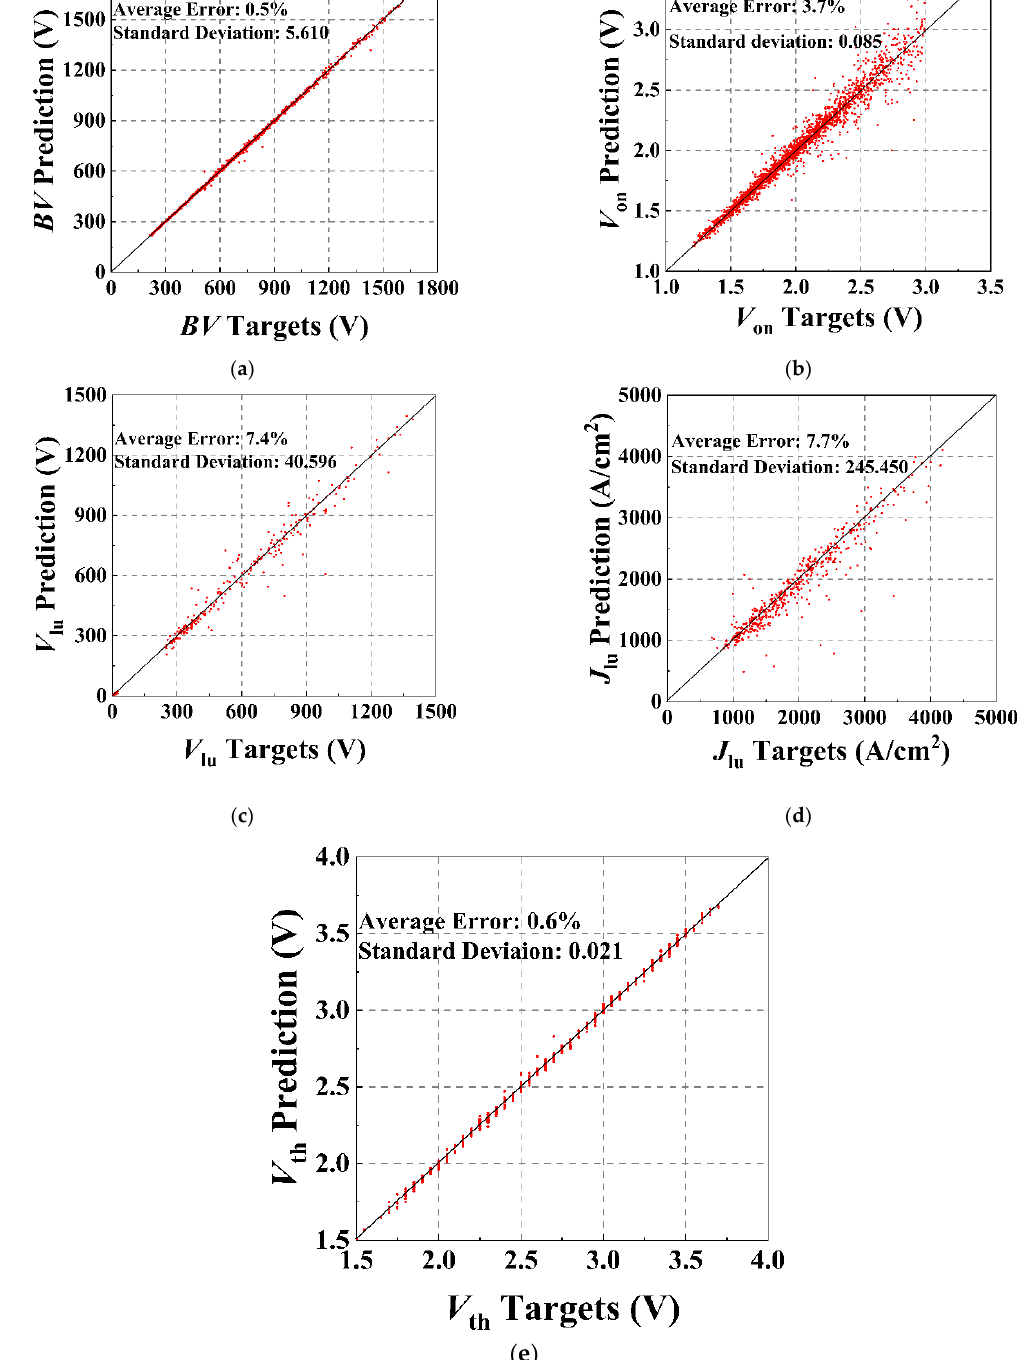
Figure 4. The scatter plots of the static characteristic prediction results for the testing sets of the IGBT: ( a ) BV , training sample size: 7600; ( b ) V on , training sample size: 7600; ( c ) V lu , training sample size: 4250; ( d ) J lu , training sample size: 4250; and ( e ) V th , training sample size: 1400.